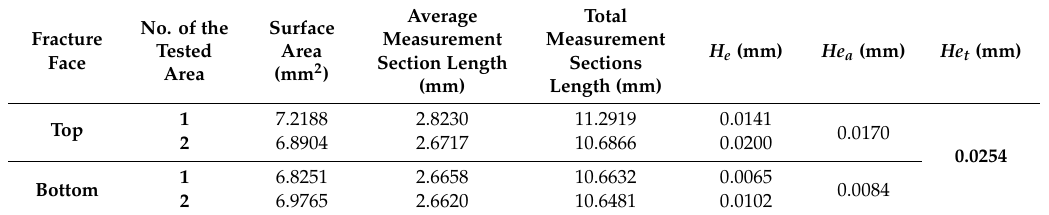
Table 2. Total average depth of proppant embedment in the fracture faces—Test no. 1.